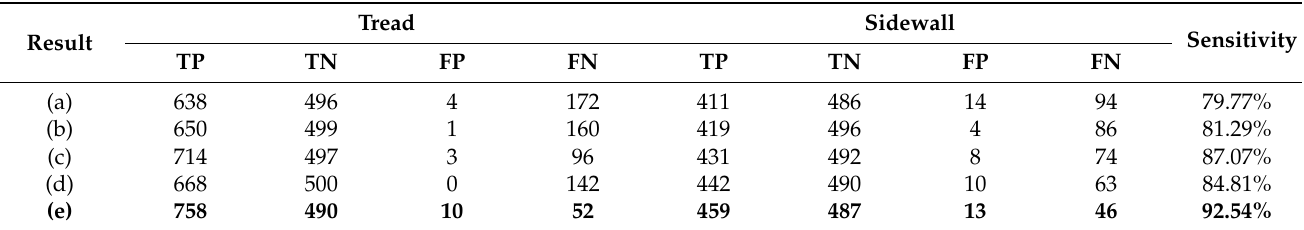
Table 8. Results Obtained by Different Architecture (a) Tiny YOLO (b) YOLOv3 (c) YOLOv3 SPP (d) Modified YOLOv3 (e) Proposed modified YOLOv3 SPP